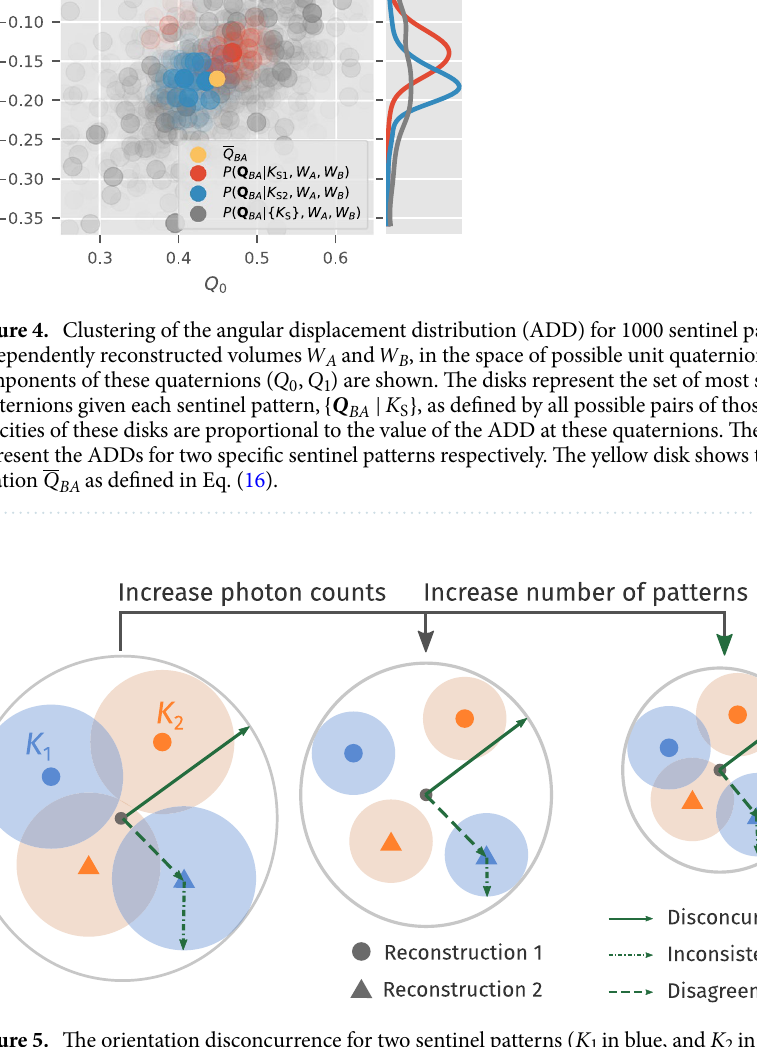
Figure 5. The orientation disconcurrence for two sentinel patterns ( K 1 in blue, and K 2 in orange) consists of two parts: the inconsistency that each model orients sentinel patterns (disk spanned by dashed-dotted radii), and the disagreement between how different models orient these patterns (disk spanned by dashed radii). These aspects are affected by the photon counts per pattern ( N ) and the number of patterns ( M data )